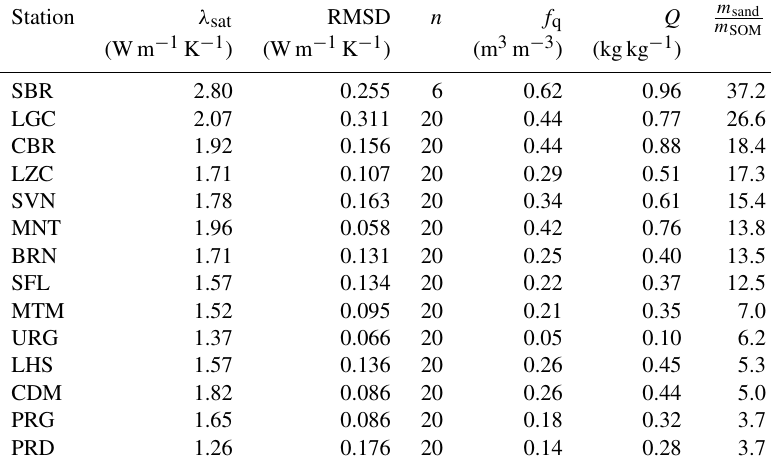
Table 2. Thermal properties of 14 grassland soils in southern France: λ sat , f q and Q retrievals using the λ model (Eqs. 7–9 and 10) for degree of saturation values higher than 0.4, together with the minimized RMSD between the simulated and observed λ values and the number of used λ observations ( n ). The soils are sorted from the largest to the smallest ratio of m sand to m SOM . Full station names are given in Supplement 1 (Table S1.1). Station λ